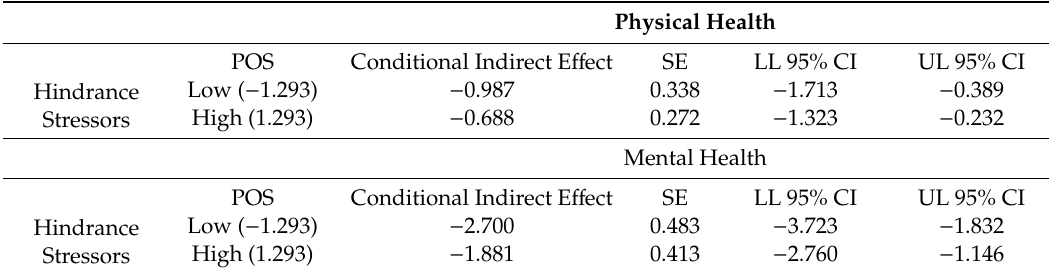
Table 4. Moderated mediation results for self-rated health across levels of